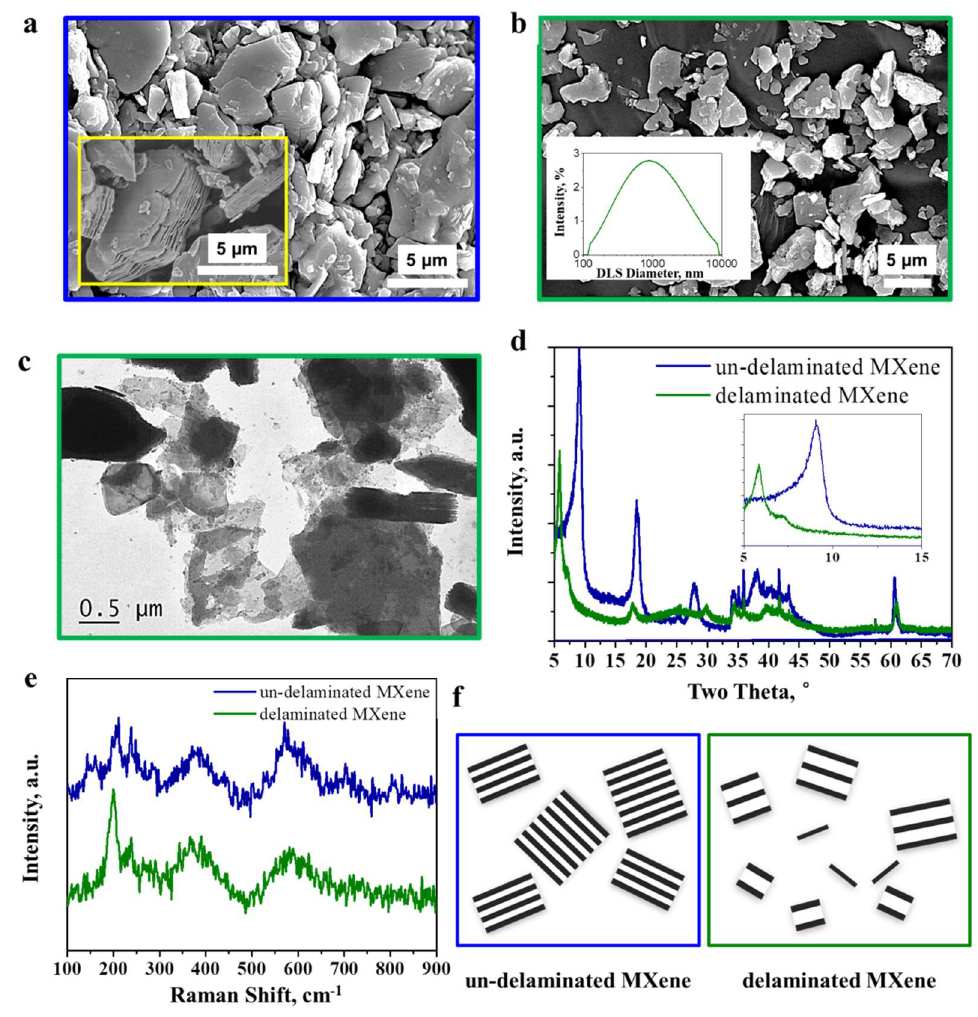
Figure 1. ( a ) SEM images of un-delaminated MXene; ( b ) SEM image of delaminated MXene and the particle size distribution (the inset); ( c ) TEM image of delaminated MXene; ( d ) XRD patterns of un-delaminated and delaminated MXene; ( e ) Raman spectra of un-delaminated and delaminated MXene; ( f ) Schematic diagram of the un-delaminated and delaminated MXene.